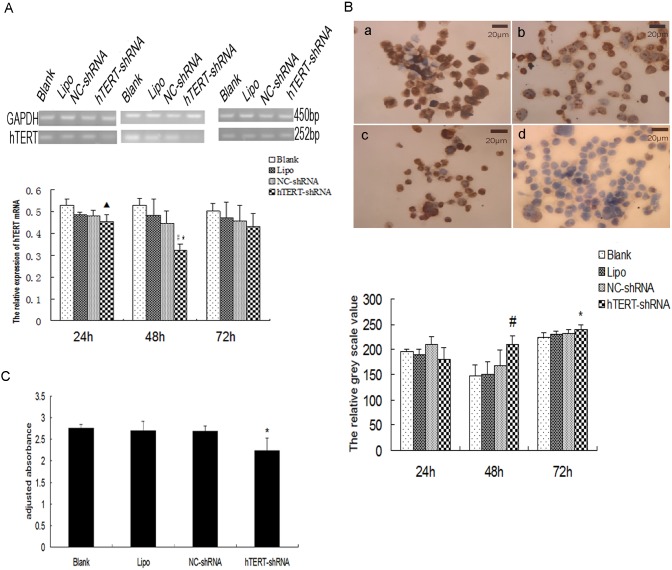
hTERT-shRNA inhibits hTERT expression and telomerase activity in vitro.(A) RT-PCR analysis of hTERT mRNA expression in SW480 cultures after mock-transfection with culture medium alone (Blank), Lipofectamine alone (Lipo), negative control siRNA (NC-shRNA), or hTERT-shRNA. Levels of mRNA levels were significantly lower after 48-h transfection with hTERT-shRNA than after control transfections. ▴
P<0.05, #
P<0.01, compared with the Blank; *P<0.05, compared with Lipo and NC-shRNA. (B) Immunocytochemistry of hTERT protein expression. (a) Blank cells, (b) Lipo cells, (c) NC-shRNA cells, and (d) hTERT-shRNA cells. All views, ×400. Higher greyscale value indicates lower protein level. Protein levels were significantly lower after 48-h transfection with hTERT-shRNA than after control transfections. #
P<0.01, compared with the other groups; *P<0.05, compared with the Blank. (C) HTERT down-regulation inhibits telomerase activity. Telomerase activity [adjusted absorbance (450 nm–630 nm)] was significantly lower in cells transfected with hTERT-shRNA than in control cells. *P<0.05, compared with the Lipo and Blank controls. Results are mean ± SD from three independent experiments.